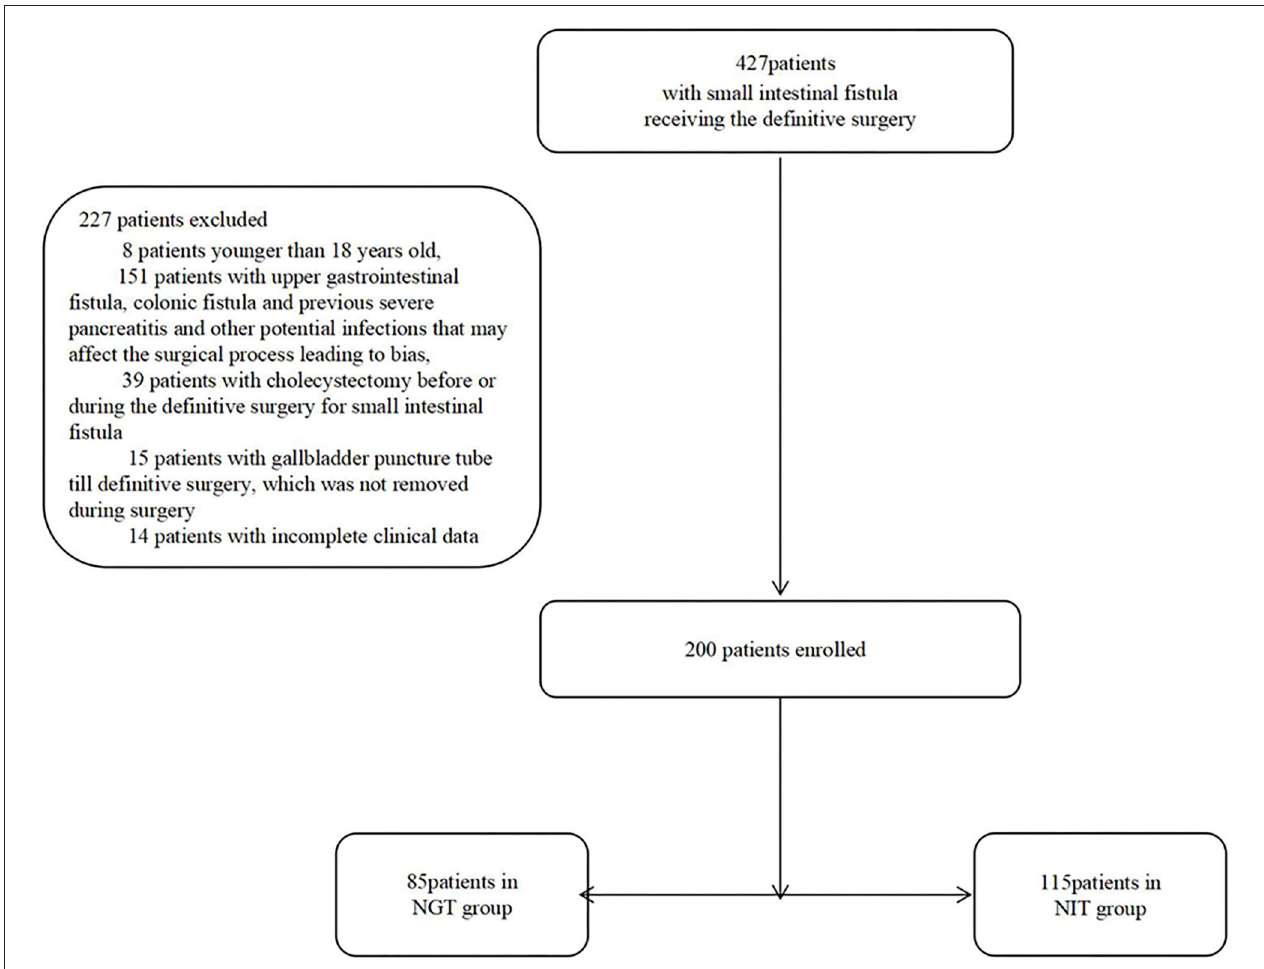
FIGURE 1 | Patients and